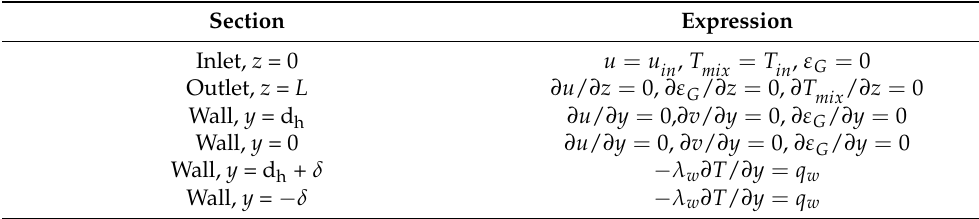
Figure 1. Two-dimensional model of the transfer processes in the microchannel. D 1 —channel domain. D 2 —solid domain. Inlet section z = 0. Outlet section z = L. Boundary conditions are listed in Table 2. Table 2. Boundary conditions for boiling liquid in the